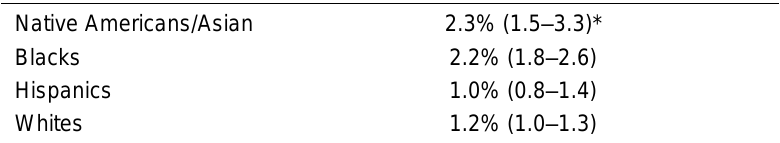
Comparison of Lifetime Prevalence of Disordered Gambling among Four Populations in the